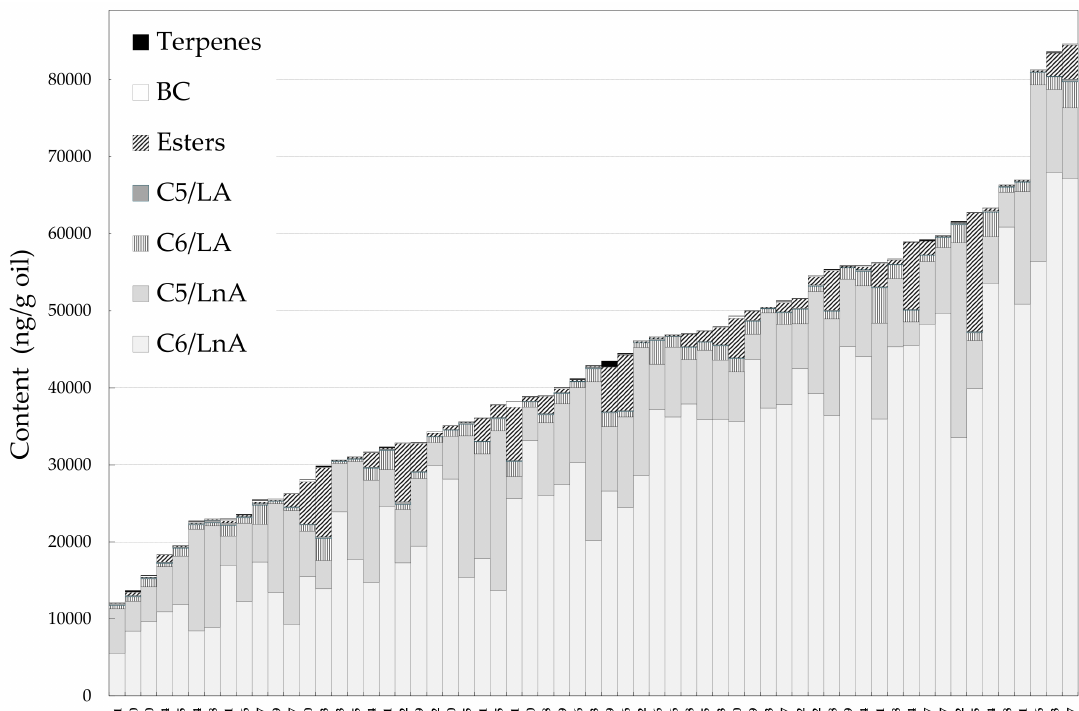
Figure 1. Content (ng/g oil) of the main groups of volatile compounds in the oils from the WOGC cultivar subset. Numbers correspond to the WOGC cultivars displayed in Table